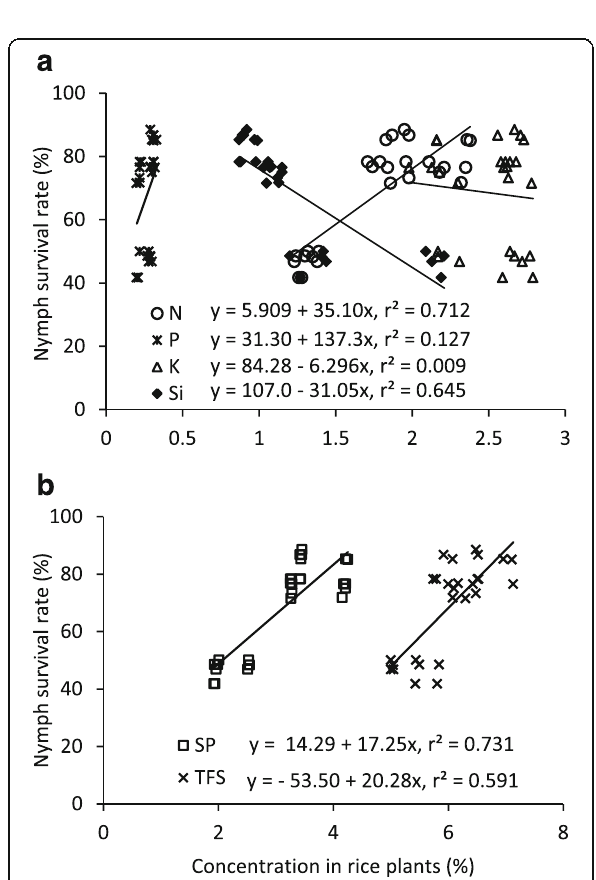
Fig. 2 Relationship of Nilaparvata lugens nymph survival rate with plant tissue nutrient concentration. a nitrogen (N), phosphorus (P), potassium (K), and silicon (Si), b soluble protein (SP), and total free sugar (TFS) content in rice plant ( n =